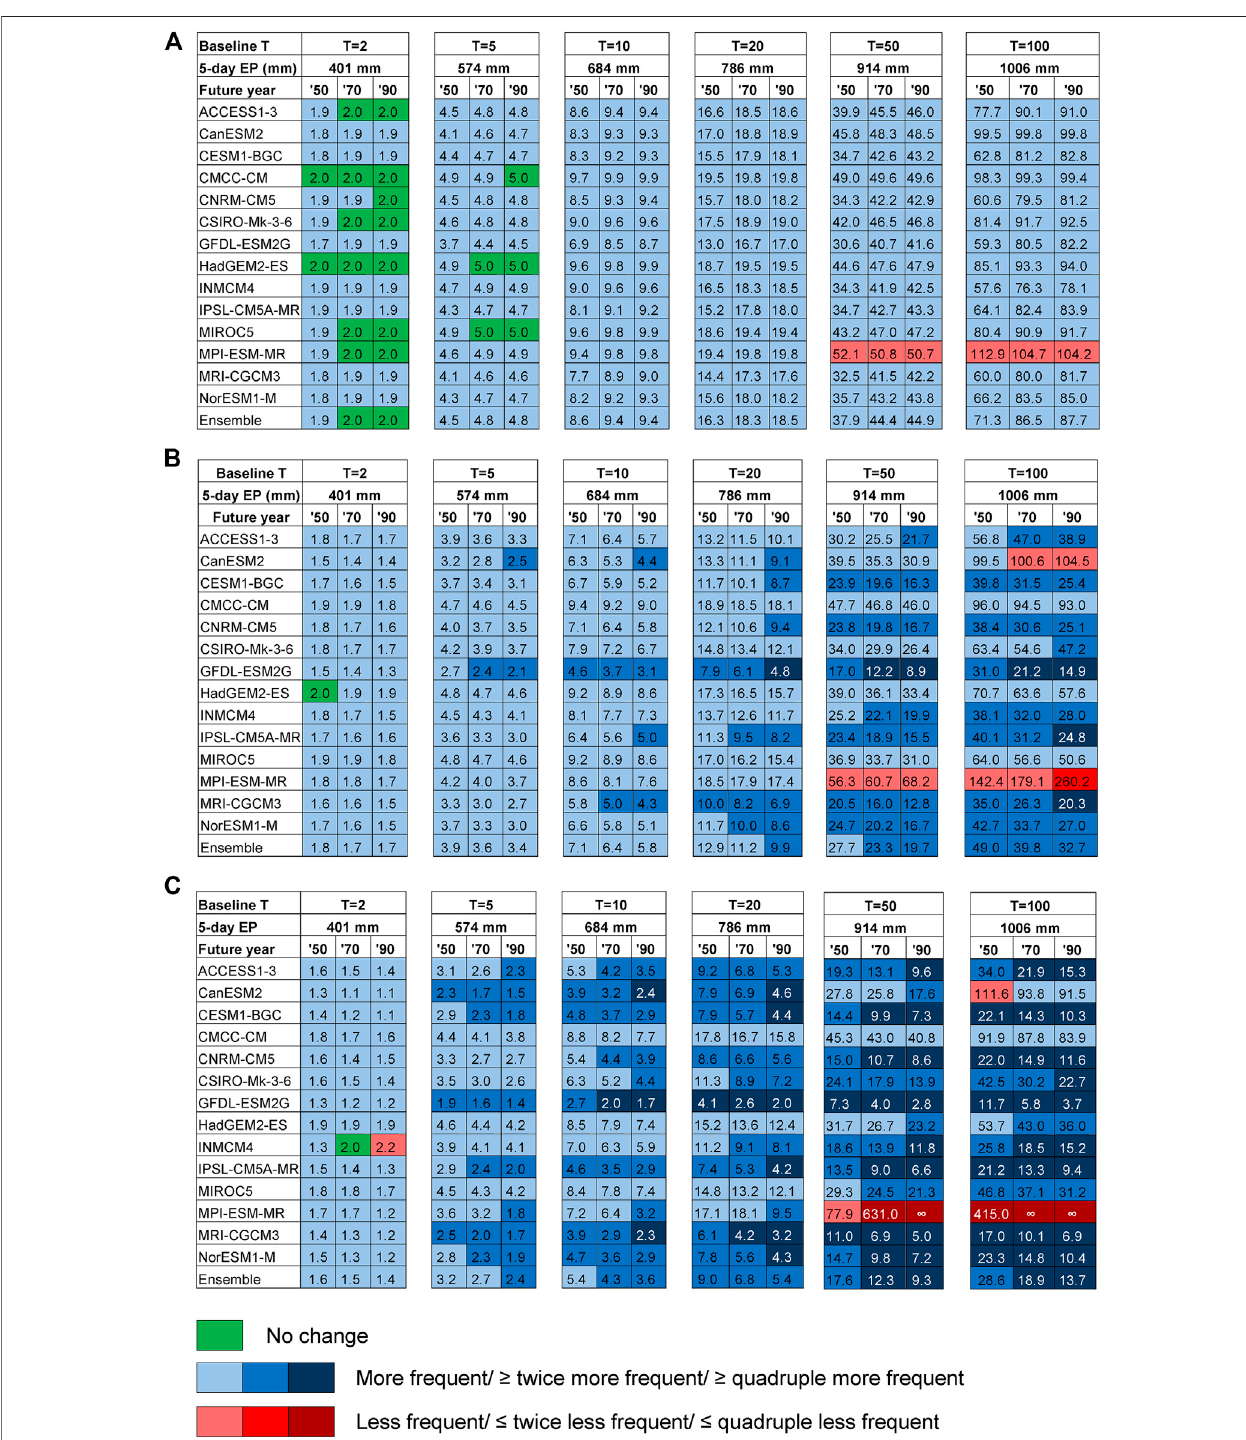
FIGURE6| ChangeinfrequencyofextremeprecipitationaccordingtoRCP2.6 (A) ,RCP6.0 (B) ,andRCP8.5 (C) .Numberineachblockpresentsthefuturereturn period of current return level.